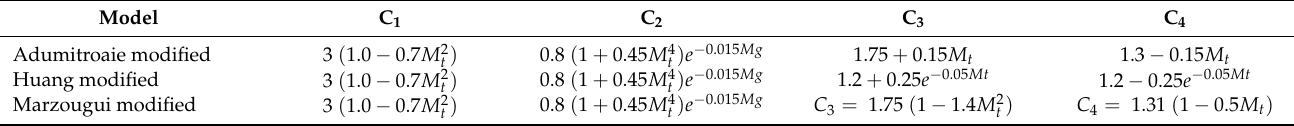
Table 2. Numerical coefficients of the pressure-strain